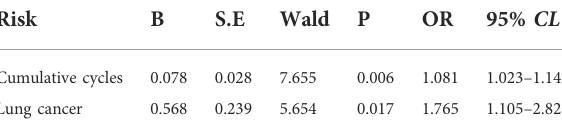
TABLE 4 Multivariable Logistic regression analysis for